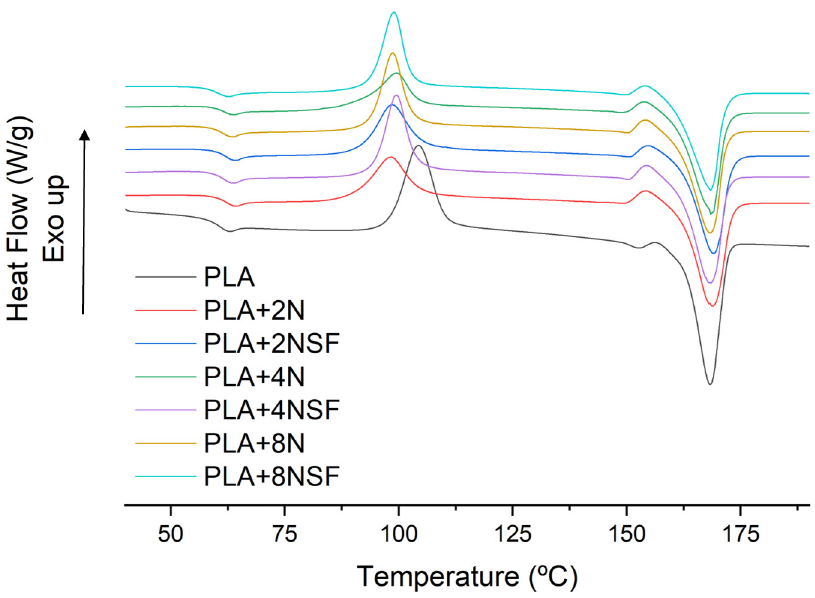
Figure 7. DSC thermographs of the second heating of all the studied materials. Main temperatures, enthalpy of the melting, and the cold crystallization and crys- tallinities are shown in Table 5 for better discussion. The T g shifted in all the materials to higher temperatures due to the presence of nanoclays. However, the lower shifts were ob- tained for NSF and high contents. The lower shifts of NSF can be related to the degradation observed in TGA and the mechanical properties obtaining lower chains. The effect of the high content is also related to the lower intercalation of the nanoclay layers. The T c of NSF is lower than the observed for hydrophilic nanoclays but enthalpy is higher than the polar ones. It is probably due to the higher dispersion and of them, enhancing the crystallization. Moreover, the lower temperatures could be also associated with the degradation of the PLA. In addition, two different peak behaviors were observed for both types of nanoclays. Hydrophilic nanoclays produced a broader peak while the NSF ones had a narrow peak. The difference in the peak behavior could be also related to the degradation of polymer chains, which could enhance also the crystallinity content. However, the melting behavior is almost the same with slightly higher temperatures for the hydrophilic ones. The enthalpy and crystallinity of the samples during the melting are almost the same for both nanoclays when the same content is used. Thus, a higher crystal content is formed during the cold crystallization of the NSF materials, while it seems that polar can enhance better the crys- tallization during the cooling process of the materials. The difference can be related to the higher interaction of PLA with NSF that can disturb the crystal growth during the cooling process. Moreover, a negative effect is observed in the crystallinity of all the materials due to the presence of